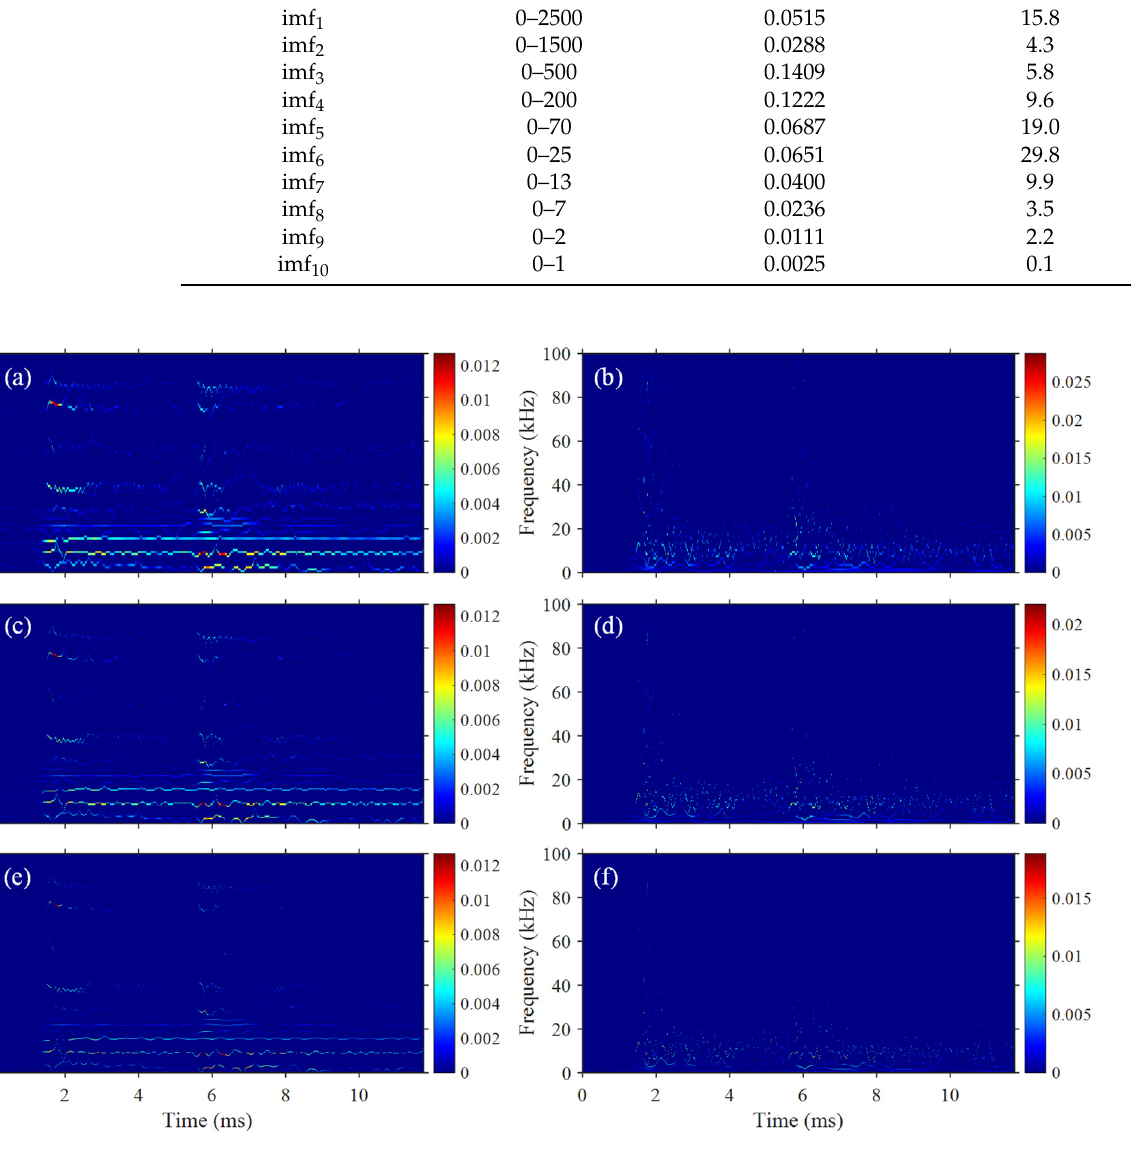
Figure 16. Comparison of the time–frequency spectra with different drawing frequency resolutions